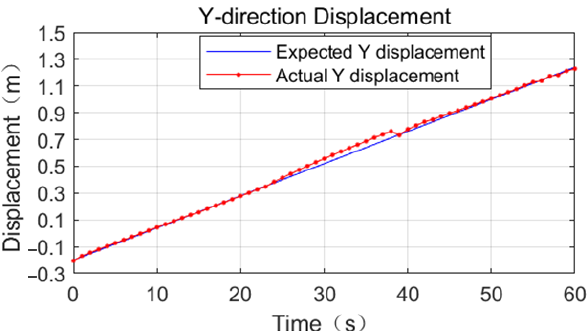
Figure 12. Comparison of expected and actual displacement in the Y-direction of base truss crawl- ing.